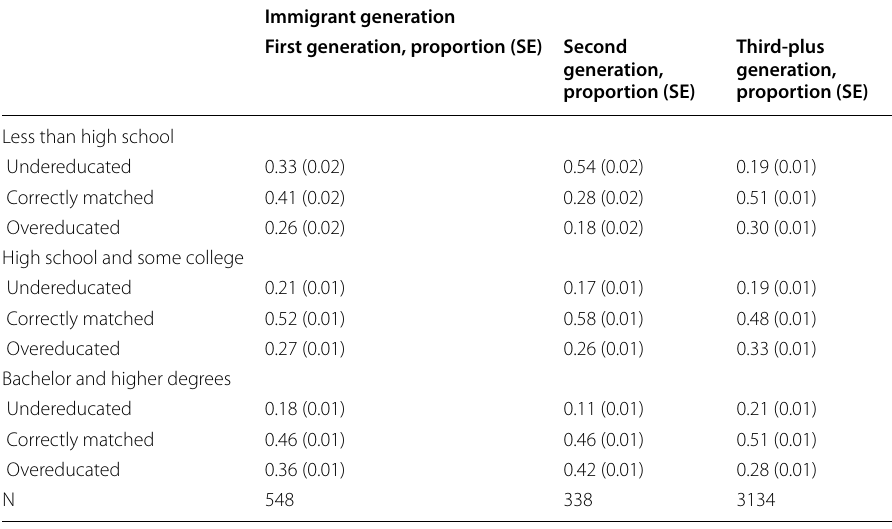
Table 2 Distribution of workers by immigrant generation, education level, and job-education mismatch, PIAAC 2012/2014